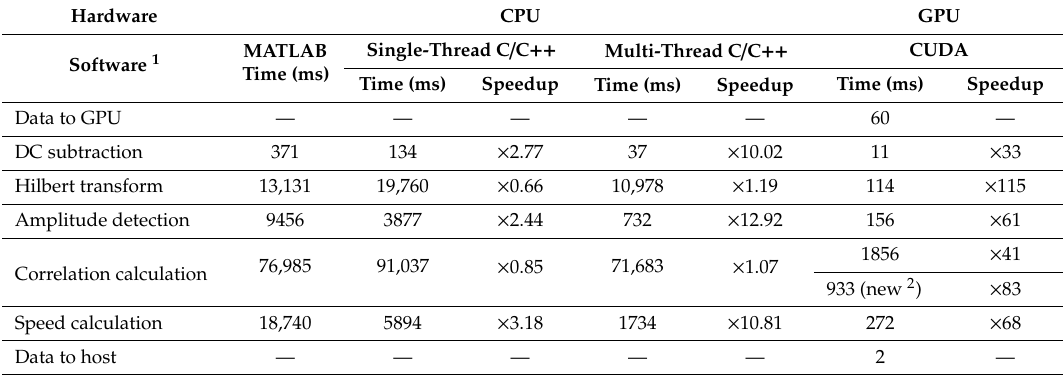
Table 2. The detailed timings and speedup for each calculation